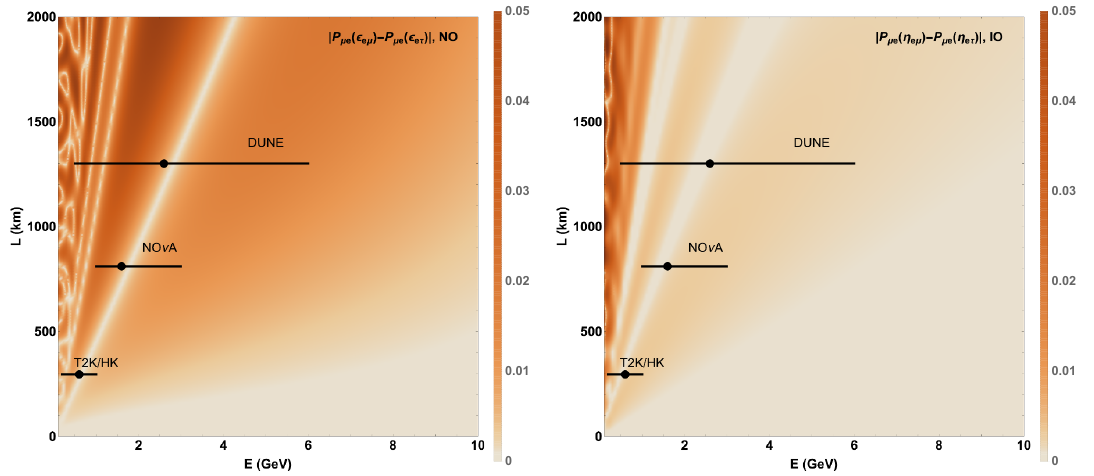
Figure 1 . The difference in neutrino appearance probabilities for two benchmark cases (see table 6) as a function of baseline and neutrino energy. On the left the difference is between the probabilities with vector NSI and ε and ε in normal ordering and the right is between probabilities with eµ eτ scalar NSI and η and η in inverted ordering. The regions probed by the different long-baseline eµ eτ experiments are indicated. The density is taken to be that for DUNE, 2.848 g/cm 3 , throughout.